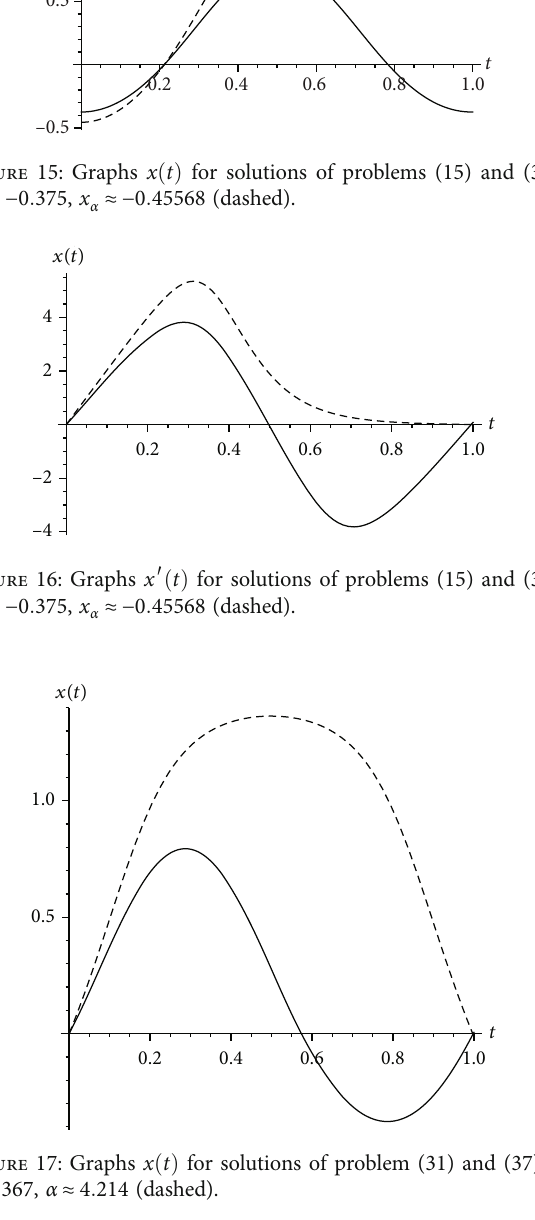
Figure 14. For initial conditions − 0 : 46 < x α < 0 , there are also